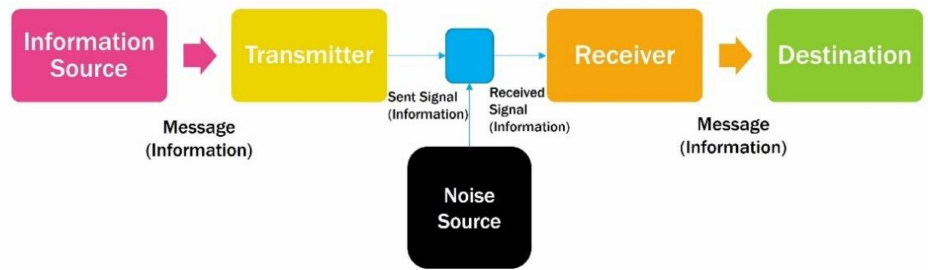
Figure 4. General information pipeline—mathematical theory of communication